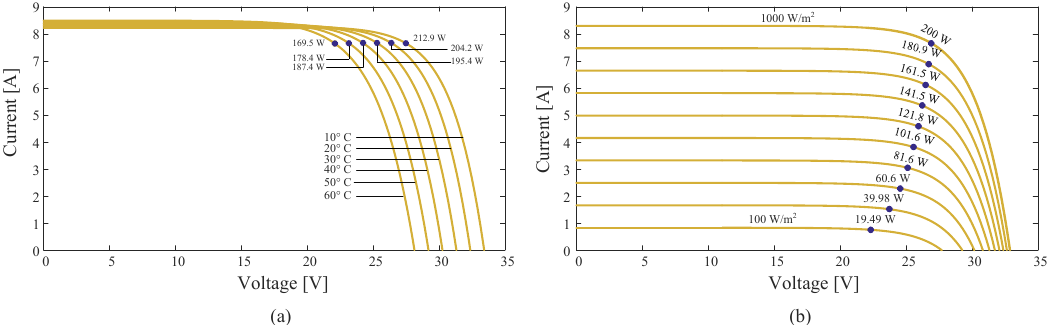
Figure 4. The I-V under variable conditions: ( a ) Under different temperature degrees. ( b ) Under different solar irradiance